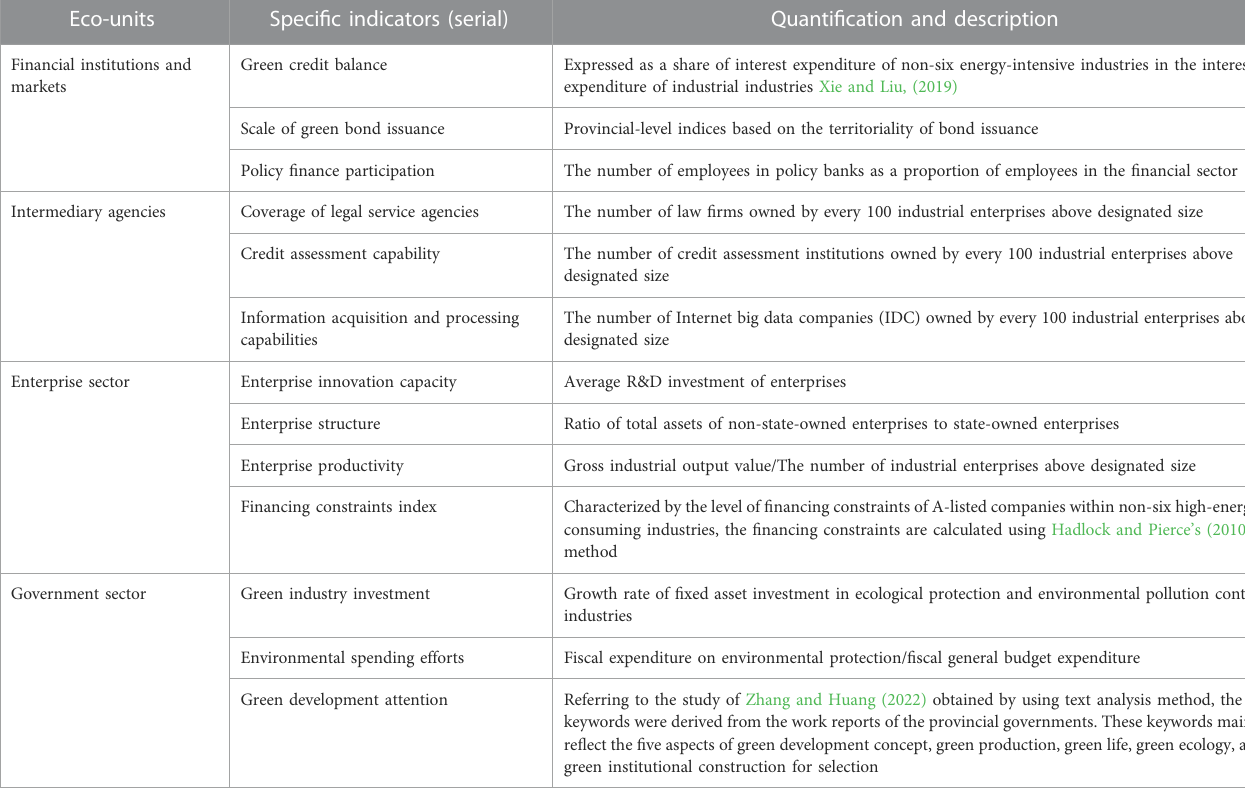
TABLE 1 Evaluation index system of the construction level of green fi nancial infrastructure.